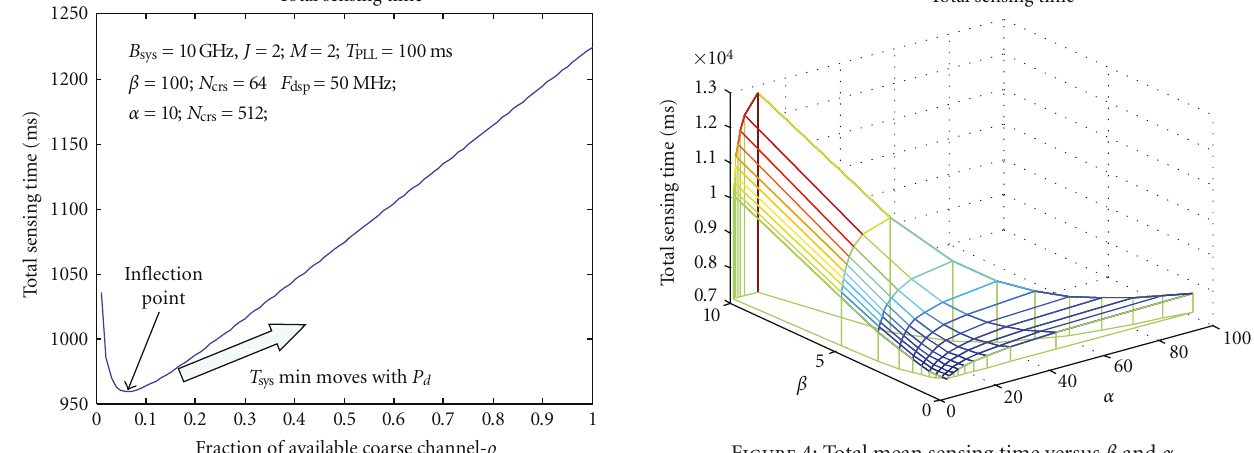
Figure 4: Total mean sensing time versus β and α